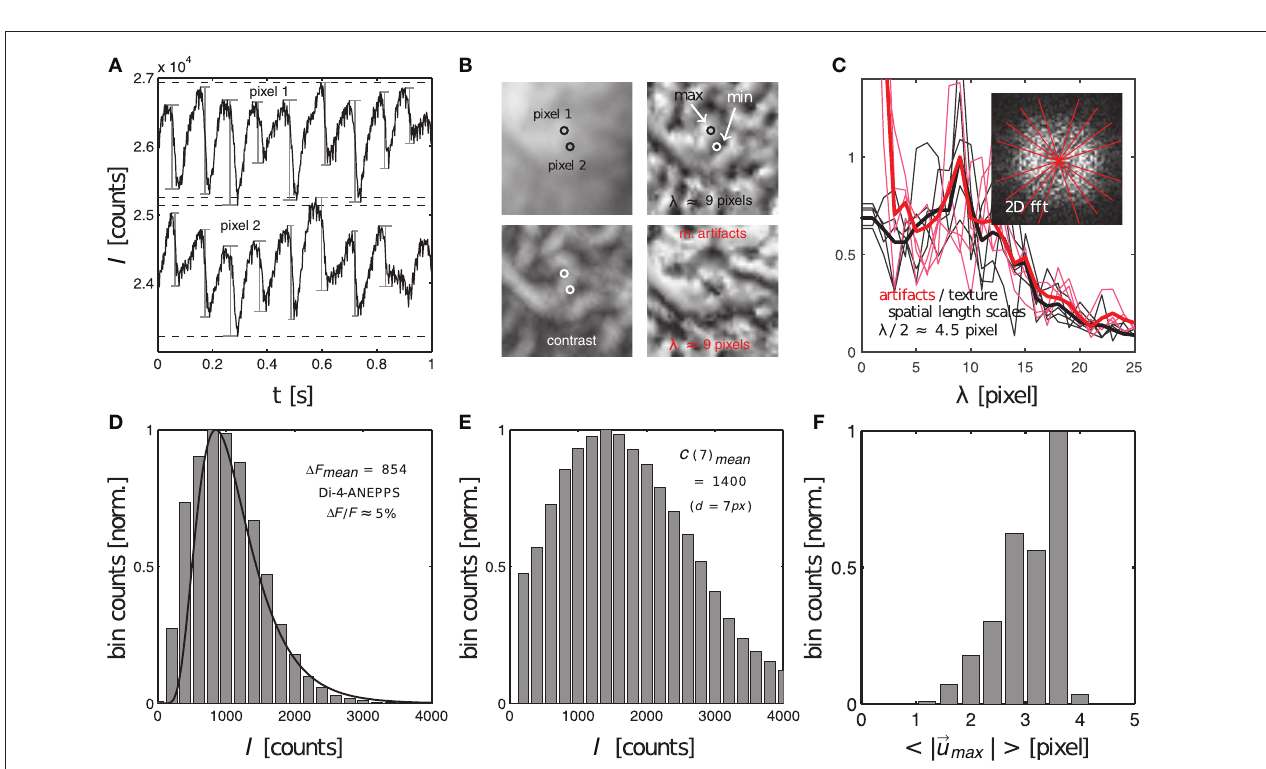
FIGURE 9 | Characterization of dissociation-related motion artifacts in optical mapping videos showing the contracting, fluorescing heart surface. Measurements of important quantifiers: fluorescent signal strength f , image contrast c , amplitude of motion |E u | and characteristic length scales λ of short-scale image gradients. (A) Action potentials measured during ventricular fibrillation in two close by pixels (see B ) on the surface of a mildly contracting rabbit heart [graph reproduced from Christoph et al. (2017)]. Difference in baseline reflects different pixel intensities. (B) Raw optical mapping video image (top left), contrast image (bottom left), contrast image normalized to local minima and maxima (top right) and motion artifacts (bottom right). All images have the same characteristic texture with the same characteristic length scale or dominant spatial frequency ( λ ≈ 9 pixels). (C) Radial profiles (fat lines: average) within 2D power spectra of spatial patterns (contrast image and motion artifacts) indicate dominant frequency of λ ≈ 9 pixels (see two overlapping peaks). (D) Fluorescent signal strength or fractional change in fluorescence 1 F (given as intensity counts I ) measured from sequences of action potentials, see (A) , with the peak of the distribution at 1 F = 854 intensity counts in 16-bit video image. (E) Image contrast (given as intensity counts I ) with peak at C = 1400 in 16-bit video image. (F) Amplitudes of motion during ventricular fibrillation (2 − 4 pixels, 128 × 128 pixel sensor size).